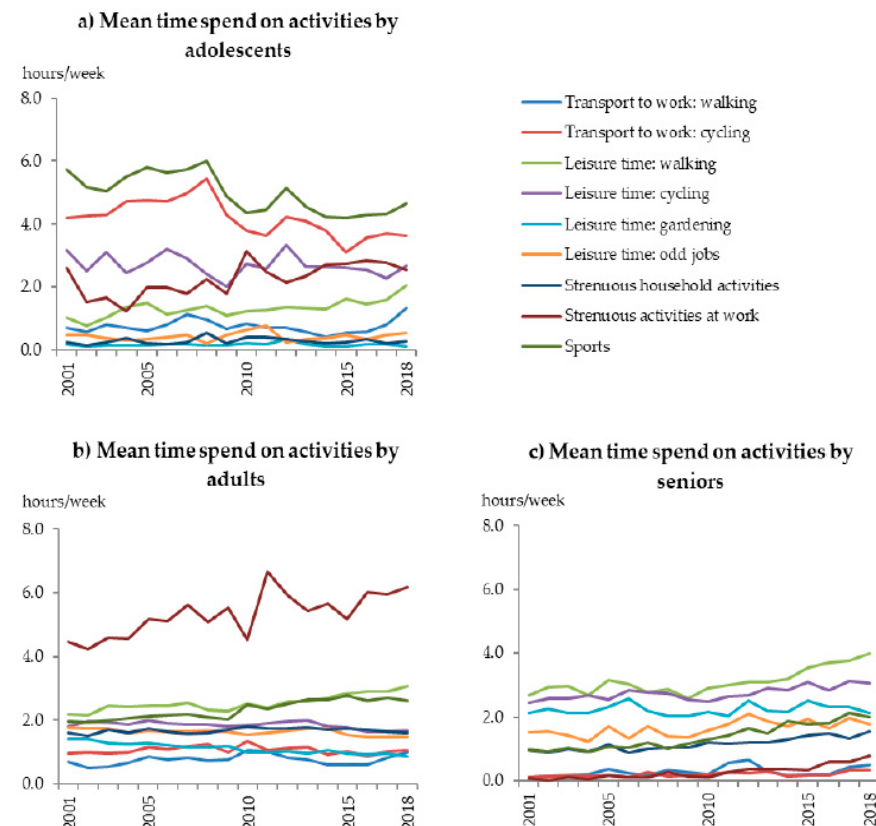
Figure 2. Mean time spend on activities at work or school, in household, during leisure time and sports per week for each year (2001–2018) stratified for age groups, ( a ) adolescents (12–17 years old), ( b ) adults (18–64 years old), ( c ) seniors (65 + years old). For adults, a small positive trend over time was observed (OR 1.017 per year [95% CI 1.014:1.019])